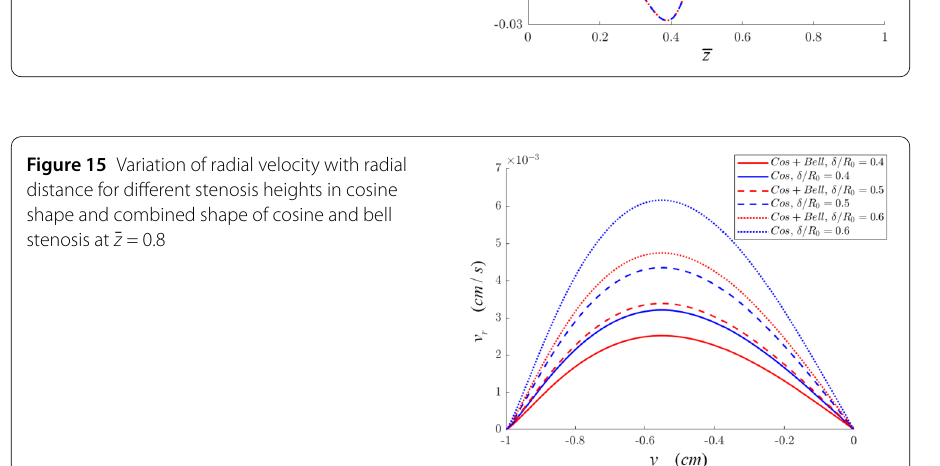
Figure 14 Variation of radial velocity with axial distance for different stenosis heights in bell shape and combined shape of bell and cosine stenosis at y = –0.5